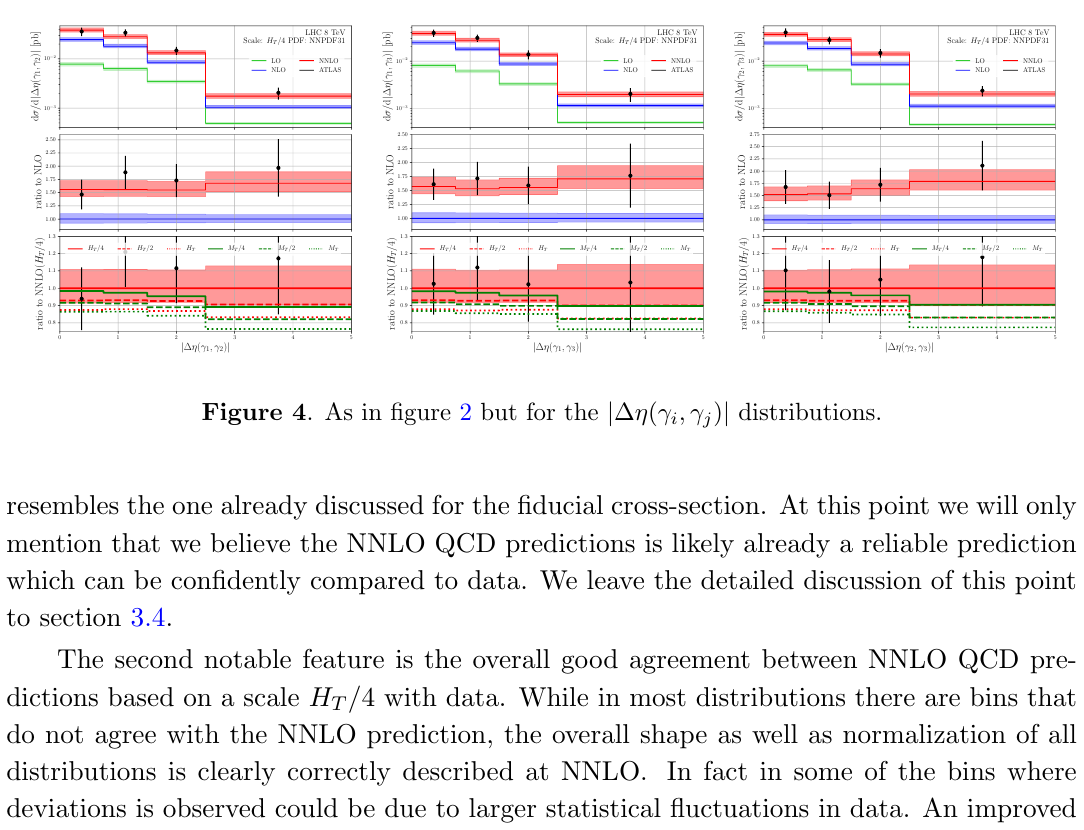
Figure 3 . As in (cid:12)gure 2 but for the (cid:1)(cid:8)( (cid:13) i ; (cid:13) j ) distributions.